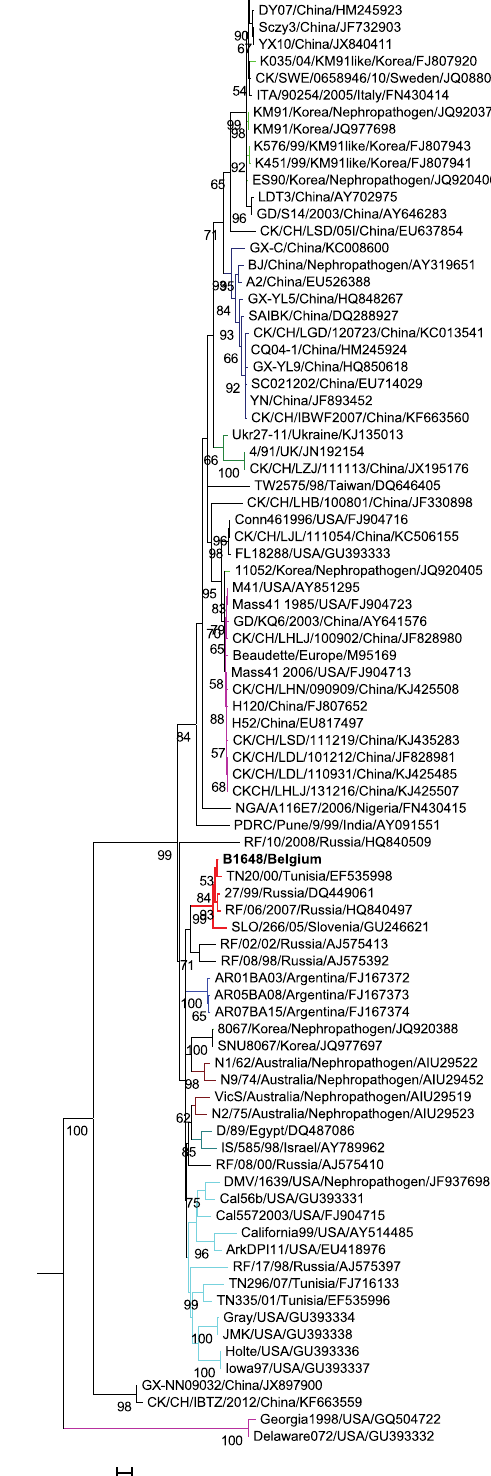
Figure 2. Maximum likelihood phylogenetic trees based on amino acid sequences of spike protein and nucleotide sequences of partial S1 gene. Bootstrap values ( n = 500 replicates) of <50% are not shown. Strain B1648 cluster is shown in red.